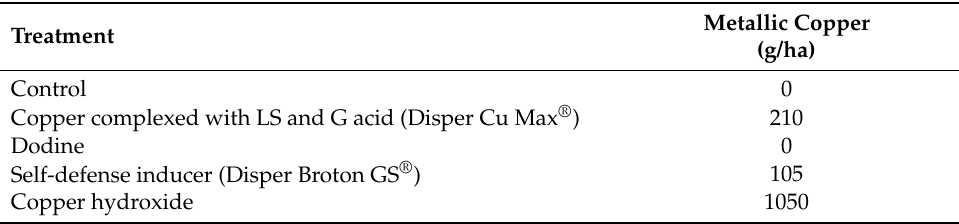
Table 1. Amount of metallic copper per treatment, considering the use of 1000 L of solution per